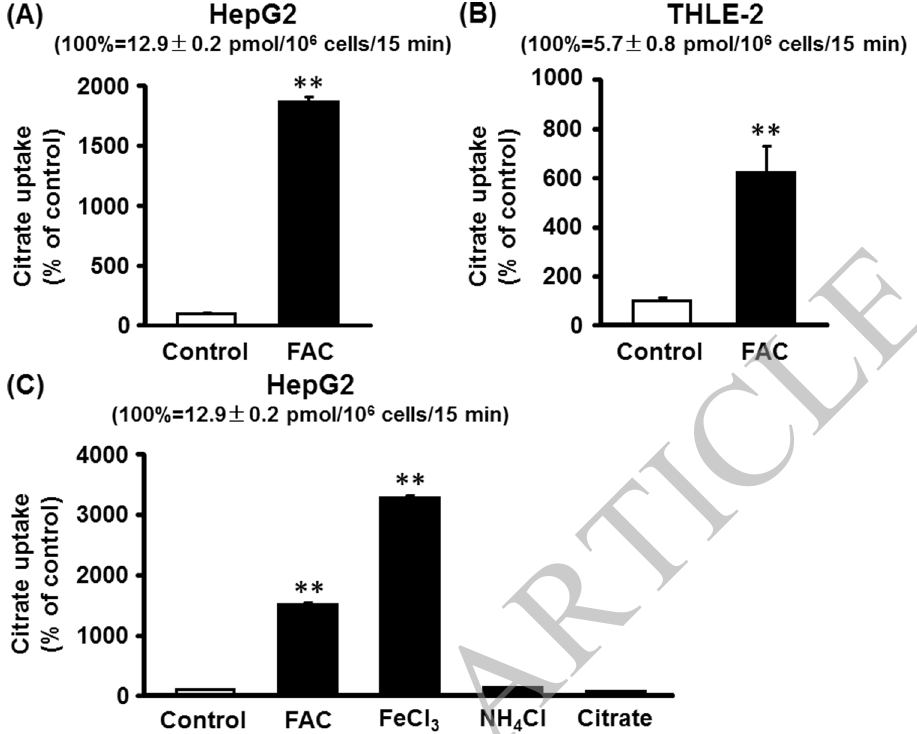
Figure 1. Effect of pretreatment with Fe 3 + on citrate uptake in a human hepatocarcinoma cell line and a human normal hepatocyte cell line. The human hepatocarcinoma cell line HepG2 ( A ) and the human normal hepatocyte cell line THLE-2 ( B ) were cultured in the absence or presence of FAC (65 μ g/ml) for two passages. The cells were then seeded for uptake measurements and cultured in the absence or presence of FAC; confluent cells were used for [ 14 C]-citrate (3.5 μ M) uptake (NaCl buffer, pH 7.5; 15 min incubation). ( C ) HepG2 cells were cultured in the absence or presence of FAC (250 μ g/ml), FeCl 3 (1 mM), NH 4 Cl (1 mM) or citrate (1 mM) for two passages. The cells were then seeded for uptake measurements and cultured in the absence or presence of FAC, FeCl 3 , NH 4 Cl or citrate. Confluent cells were used for [ 14 C]-citrate (3.5 μ M) uptake (NaCl buffer, pH 7.5; 15 min incubation). ** p <